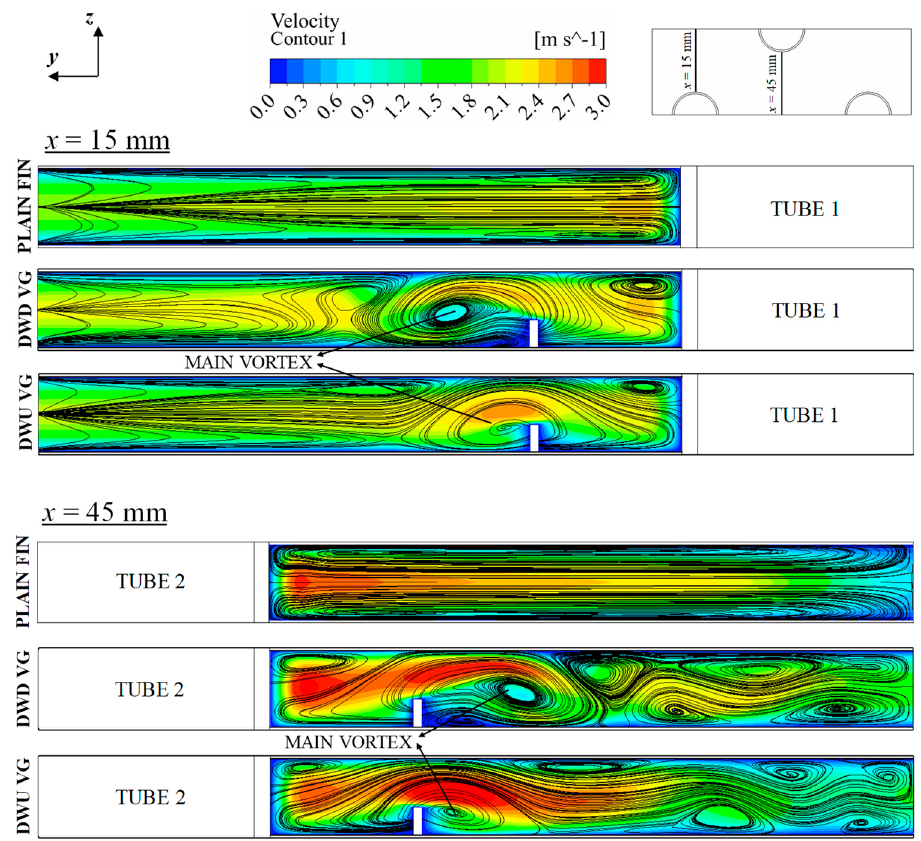
Figure 17. Air streamlines on the cross − sections x = 15 mm and x = 45 mm for air − to − water FTHEXs with plain fins and fins with DWD and DWU types of vortex generators at α vg = 45°. Test conditions: T air,in = 22 °C, T water,in = 40 °C, w air,in = 1.03 m/s, w water,in = 0.76 m/s.